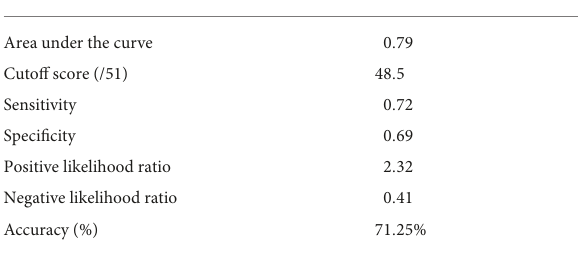
TABLE 4 Cutoff points for the summation score of section I, III, and IV from the BESTest with associated area under the curve of receiver operating characteristic curve, sensitivity and specificity, and likelihood ratios in older adults with and without disability ( N =